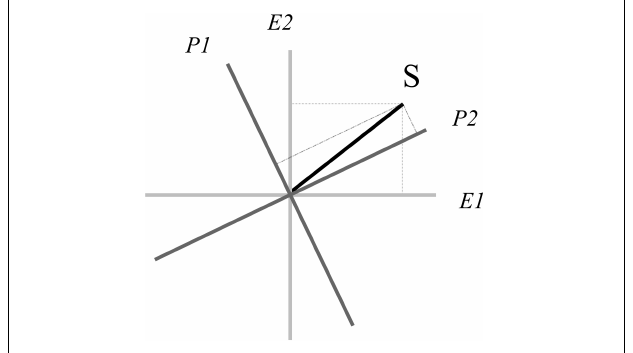
FIGURE 3 | Incompatibility between predictions (P) and evidence